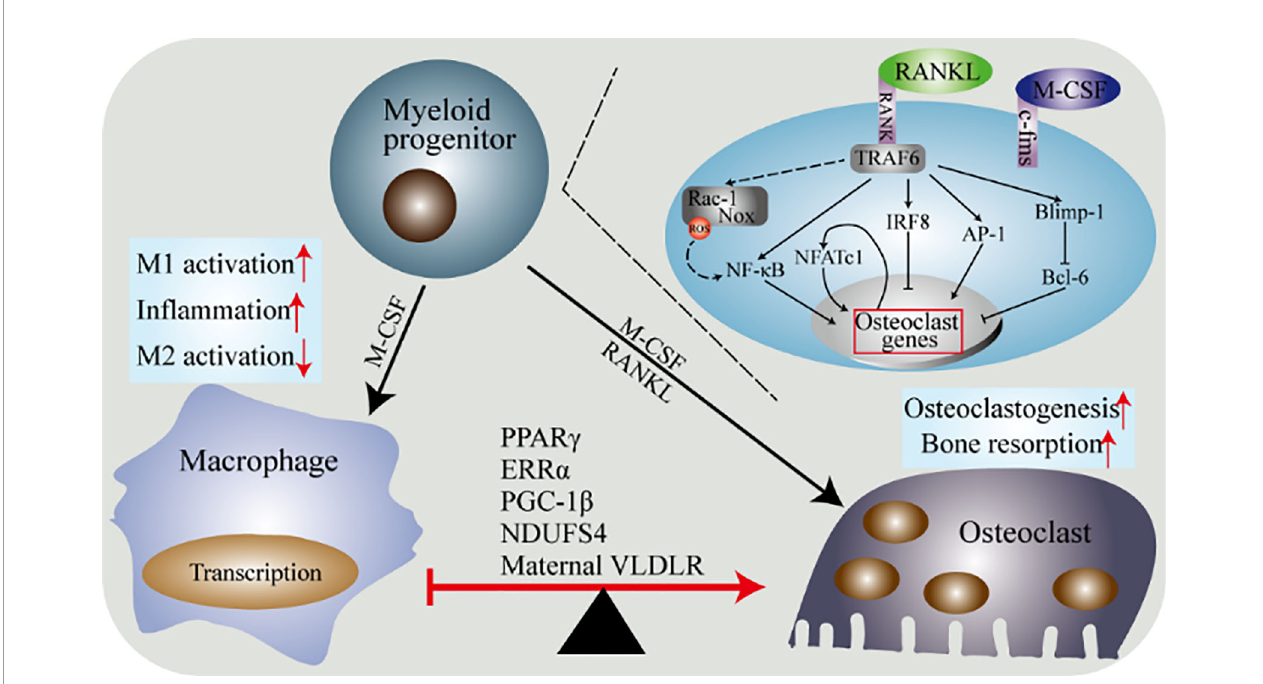
FIGURE 4 | Molecular determinants of the differentiation of macrophages and osteoclasts. Macrophages and osteoclasts are the result of two competing differentiations of myeloid progenitor. Under the stimulation of M-CSF, myeloid progenitor differentiates into macrophages. Under the dual stimulation of M-CSF and RANKL, myeloid progenitor differentiates into osteoclasts. The differentiation of macrophages into osteoclasts is regulated by multiple factors. PPAR g , ERR a , PGC- 1 b , Ndusf4 and maternal VLDLR are currently widely recognized. The combination of RANK and its ligand and the combination of M-CSF and c-fms trigger the activation of multiple downstream pathways of osteoclasts precursor to induce osteoclasts